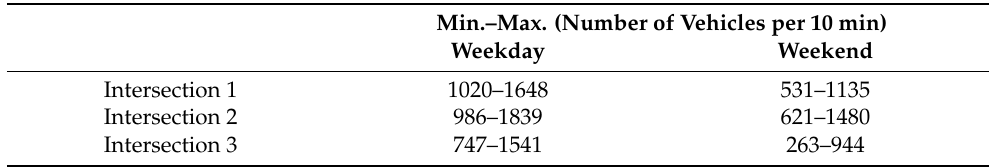
Table 3. Range of total traffic volumes during the measurement time period analyzed in each measurement